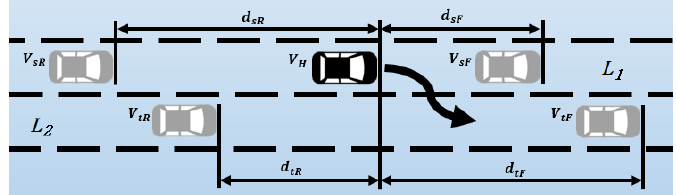
Figure 6. The traffic scenario used for lane change simulation. V H is changing from L 1 to L 2 . The traffic vehicles in L 1 and L 2 are labeled V sF , V sR , V tF and V tR . d sR = d tF = 30 m, d sF = d tR = 20